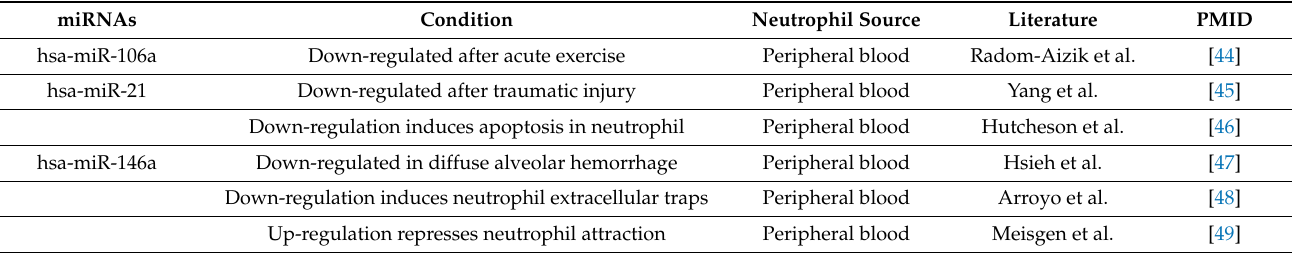
Table 1. miRNAs associated with neutrophil regulation.